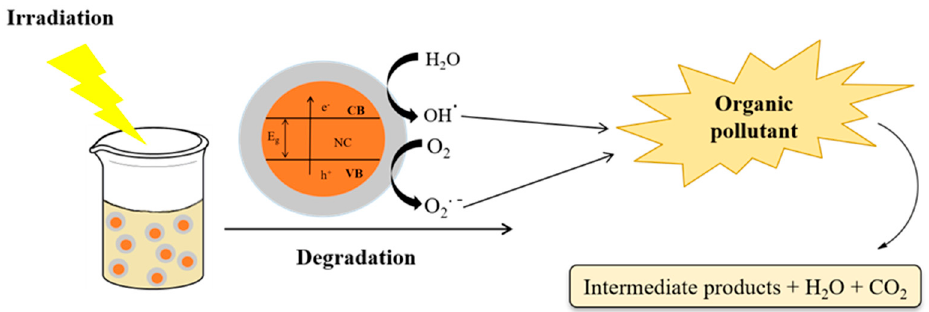
Figure 1. Scheme showing degradation of organic pollutants by heterogeneous photocatalysis. Table 2. Photocatalytic degradation of pesticides using supported